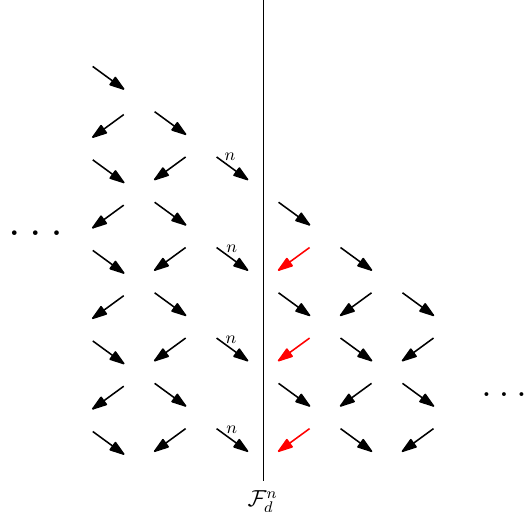
Figure 3. Filter F n . Red arrows correspond to steps ( d + 1, y + 1 ) 2 −→ ( d , y + 2 ) that has a weight 2. d Black arrows with superscript n correspond to steps ( d , y ) n −→ ( d + 1, y + 1 ) . Other steps have weight